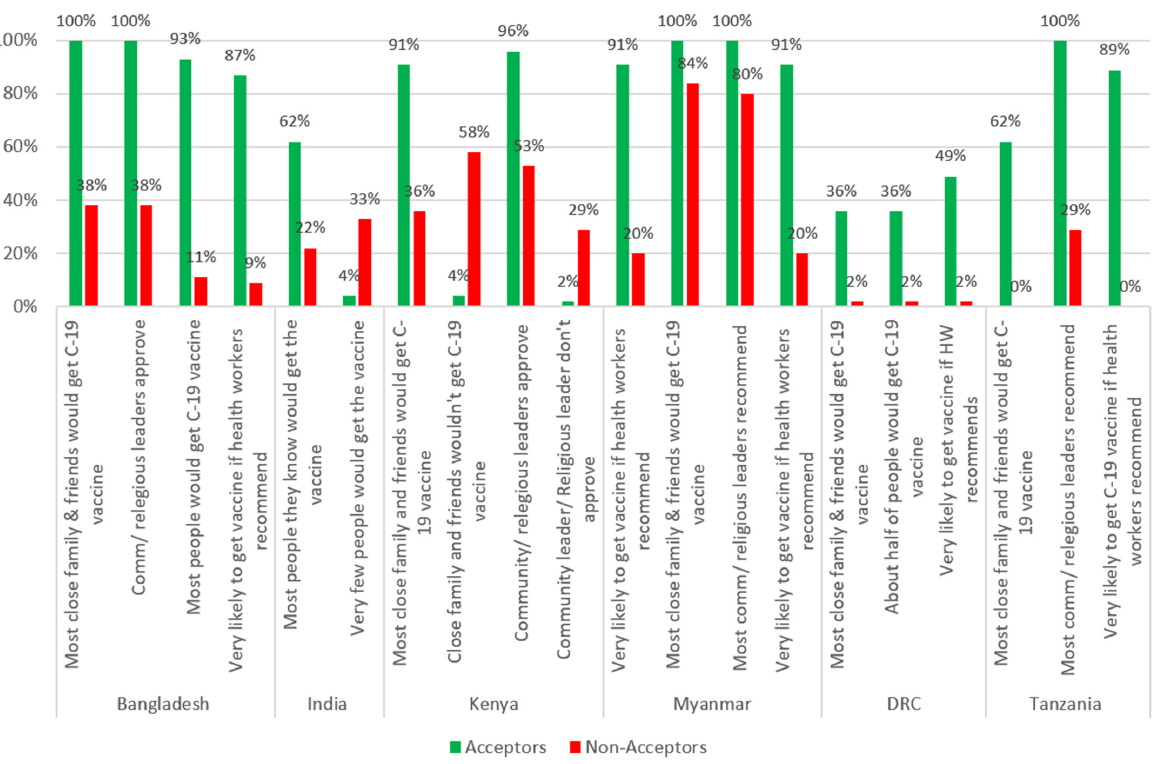
Figure 1. Perceived social norms on COVID-19-vaccine hesitancy.